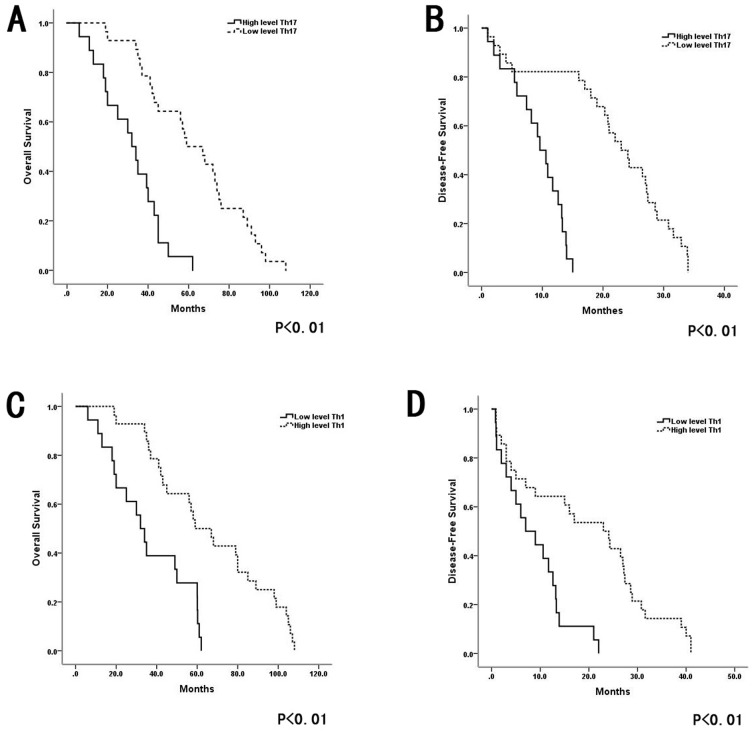
Densities of IL-17-producing cells and IFN-γ-producing cells predicted survival in patients with HCC.(A and B)Individuals with high intratumor densities of IL-17- producing cells had significantly shorter OS and DFS than those with low densities. (C and D)Patients with high intratumor densities of IFN-γ- producing cells had significantly longer OS and DFS than those with low densities.